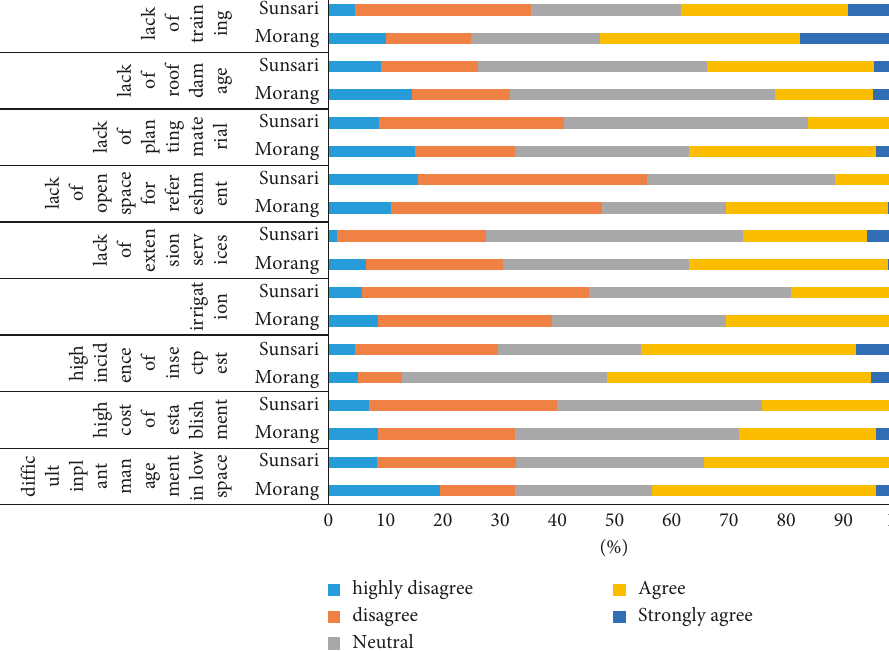
Figure 9: Constraints faced by rooftop